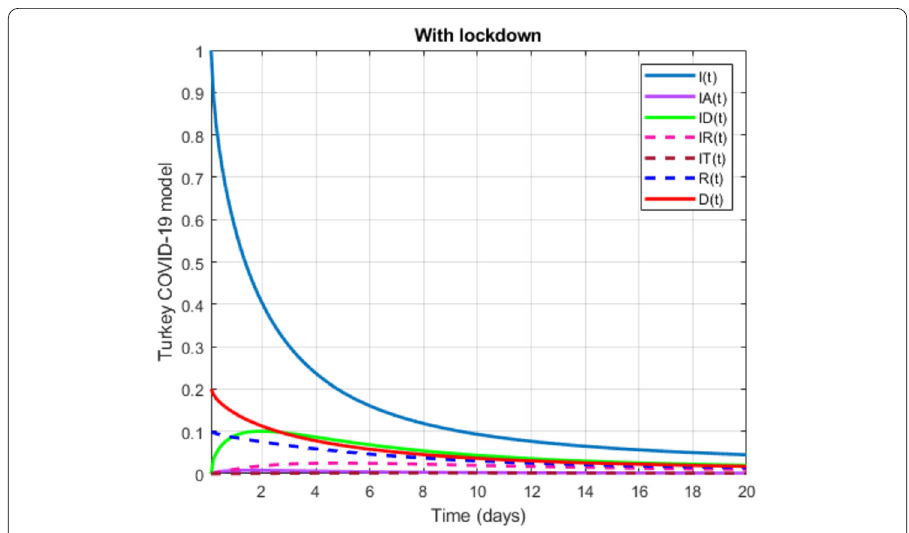
Figure 40 Numerical visualization for Covid-19 model in Turkey for α =